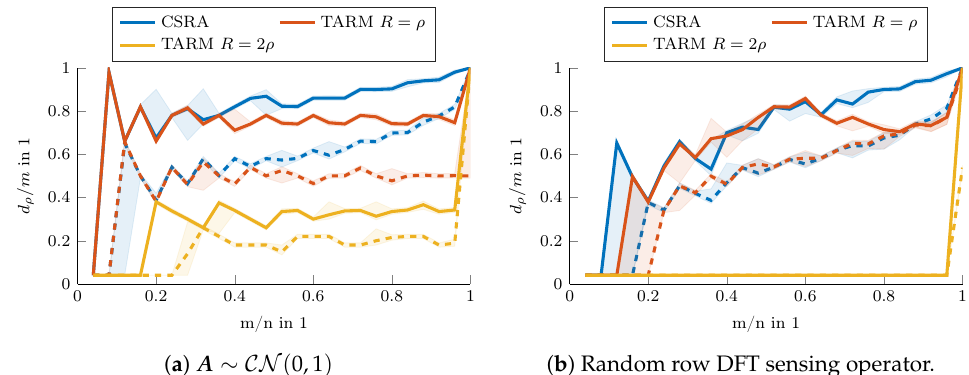
Figure 15. Comparison of reconstruction performances of TSVT + CSRA to TARM. The solid lines show the 50% success rate for a strict reconstruction success, defined as SRE ≤ − SNR, and the dashed lines the success rate for a less strict success definition, i.e., SRE ≤ − ( SNR − 5dB )